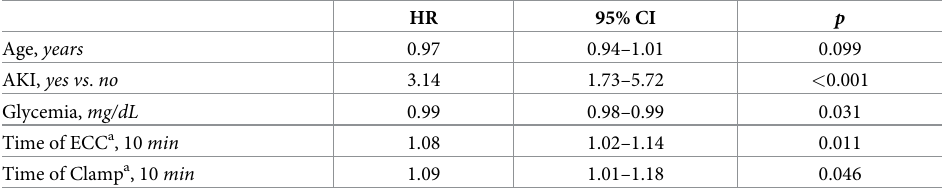
Table 5. Mortality risk by baseline patients’